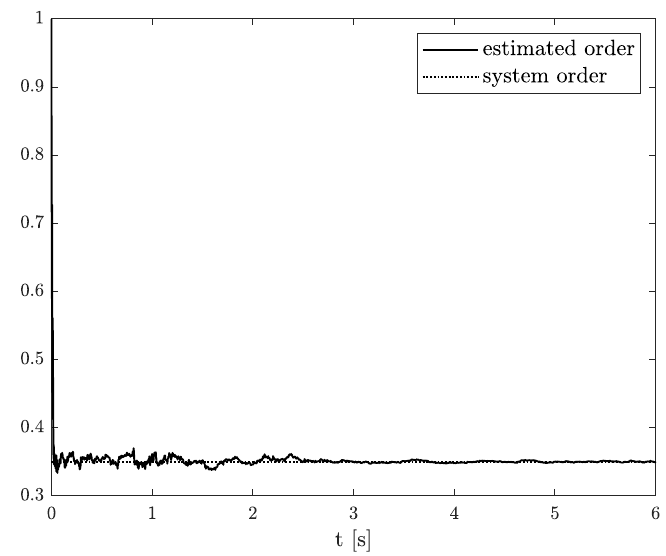
Figure 3. Original and estimated order from Example 1.